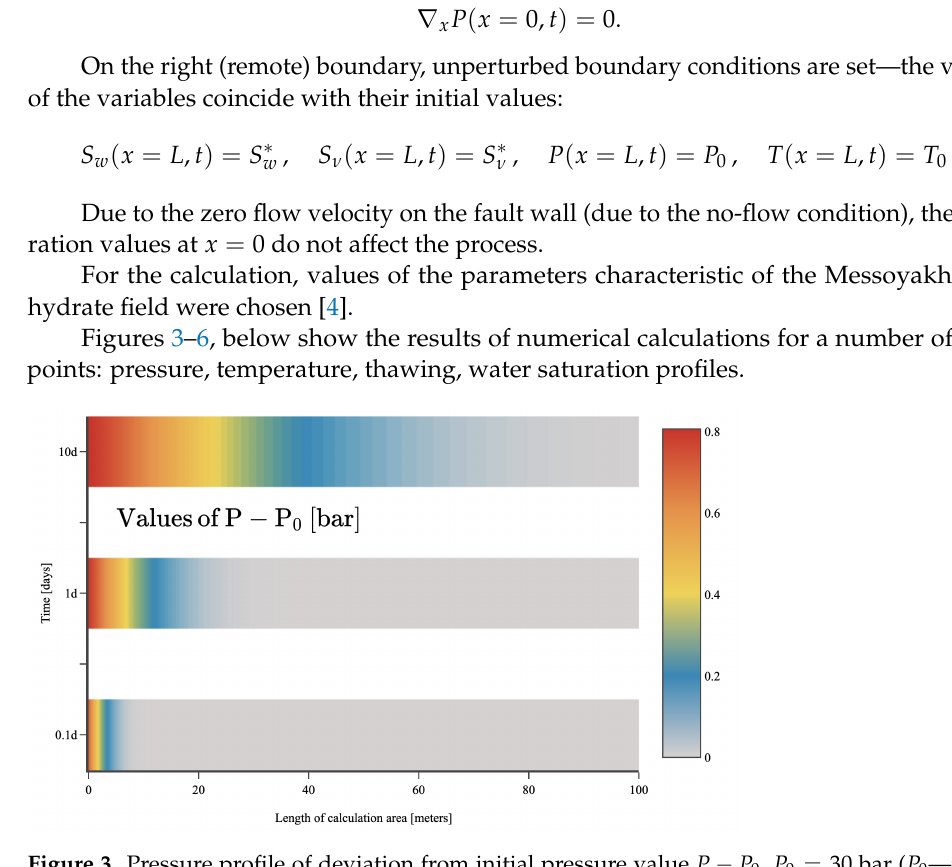
Figure 3. Pressure profile of deviation from initial pressure value P − P 0 , P 0 = 30 bar ( P 0 —initial value, P —instantaneous value), for time moments t = 0.1, 1, 10 days. X-axis: calculation length in horizontal direction of the reservoir is taken long way from the fault (up to 100 m), where 0 X-value represents the